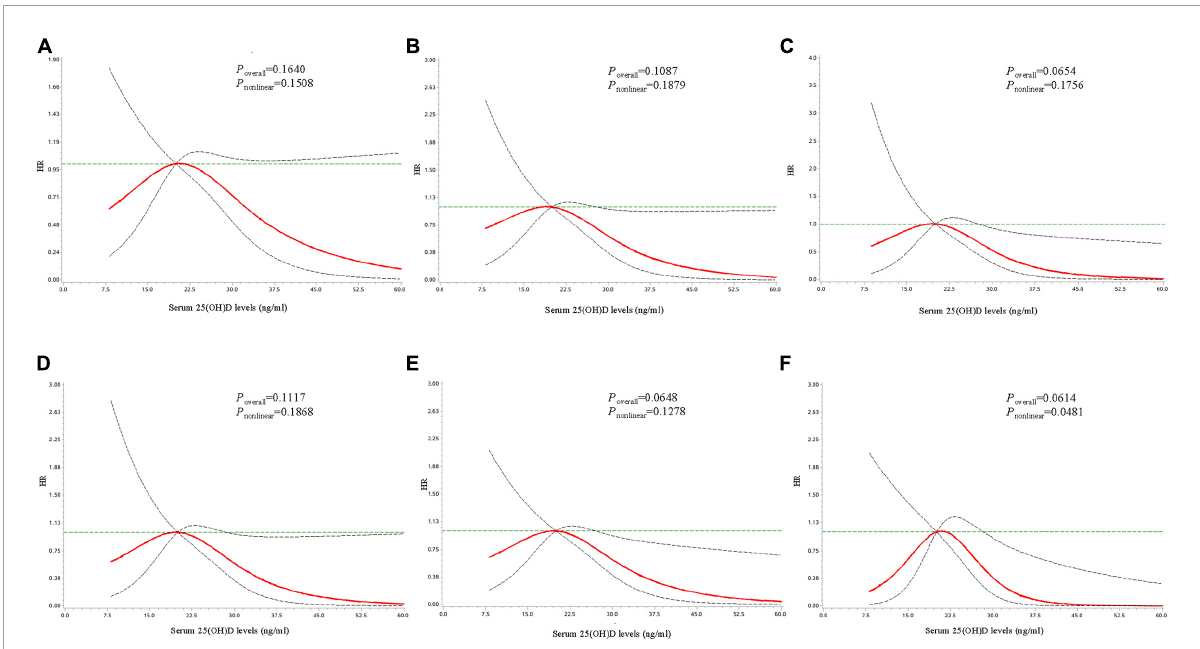
FIGURE1 Dose-response curves for the associations between serum 25(OH)D concentrations with risk of developing type 2 diabetes. Dose-response curves for the associations between serum 25(OH)D with risk of developing type 2 diabetes in the total population (A) , among individuals with age ≥ 52 years (B) , with male gender (C) , with overweight/obesity (D) , with insufficient physical activity (E) , and with fasting plasma glucose < 5.6 mmol/L at baseline (F) . The solid line and dashed line represent the adjusted estimated HRs and 95% confidence intervals. Analyses were adjusted for age, gender, body mass index, district, education level, fasting plasma glucose, hypertension, dyslipidemia, smoking status, alcohol drinking, physical activity, and family history of diabetes.